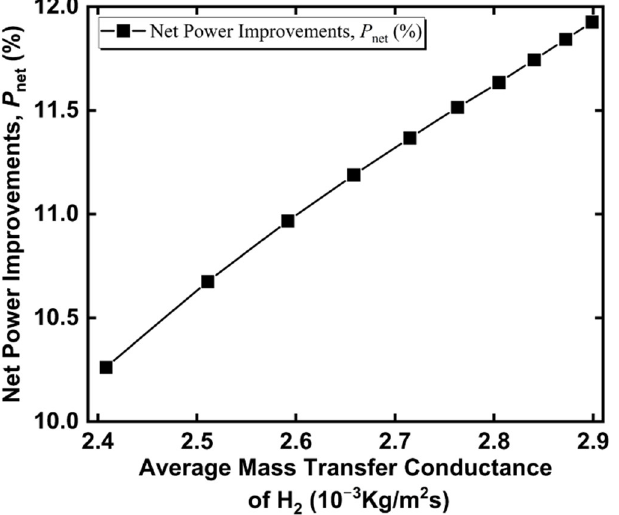
Figure 17. The percentage of the net power density improvements as a function of the average mass transfer conductance of H 2 .